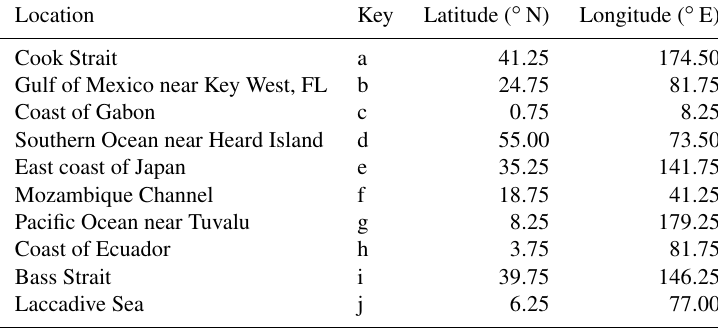
Table 2. Coordinates of chosen locations.